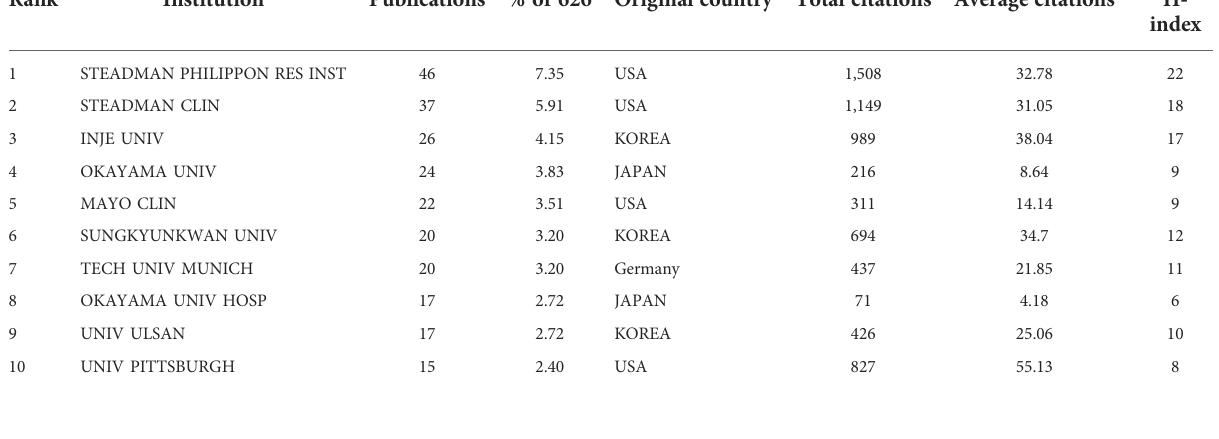
TABLE 2 Top 10 institutions distributed by publications and centrality.